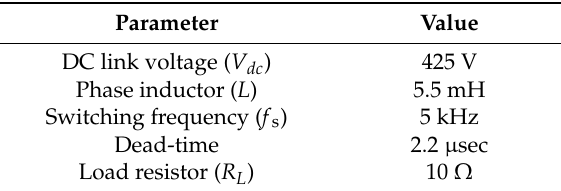
Table 1. Simulation parameters.